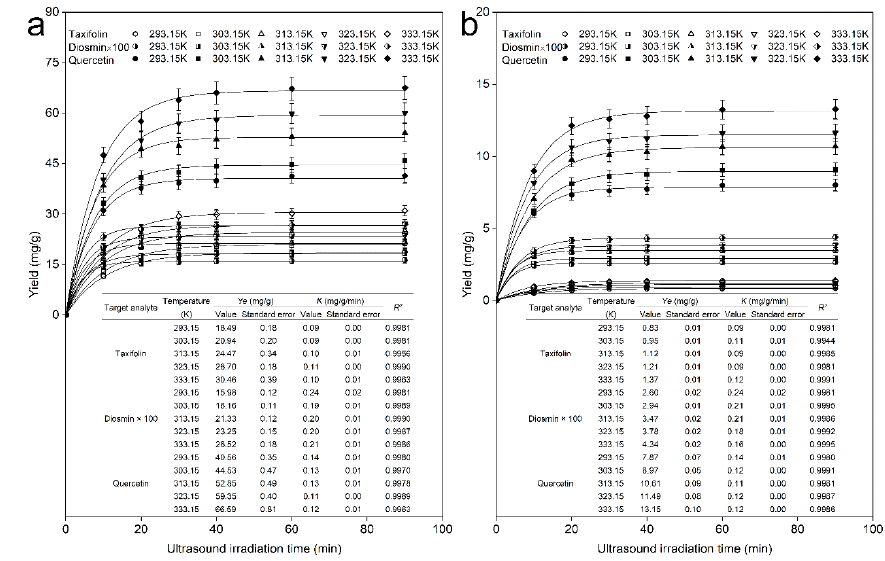
Figure 6. Dynamic curves for taxifolin, diosmin, and quercetin with various reaction temperatures (293.15 K, 303.15 K, 313.15 K, 323.15 K, 333.15 K, and 343.15 K) from Abies nephrolepis leaves ( a ) and bark ( b ).